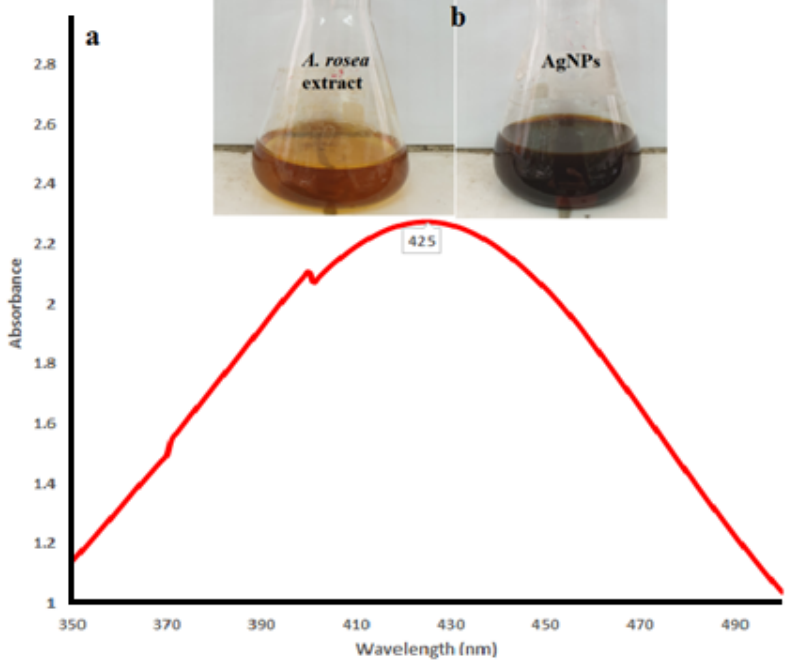
Fig. 1. A: UV - visible spectrum of silver nanoparticles b) color change related with plasmon resonance of colloidal AR@ AgNPs.